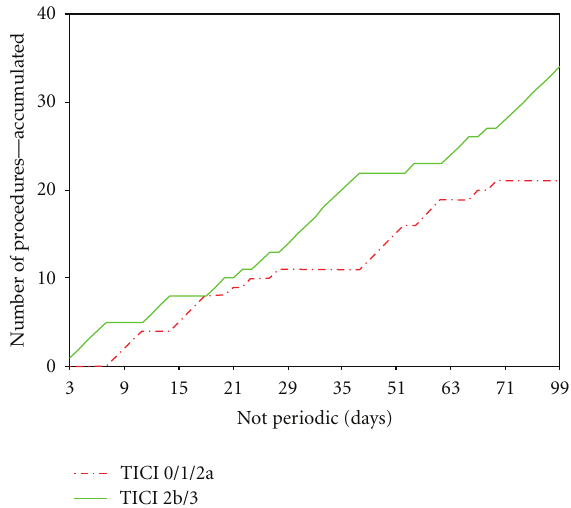
Figure 5: The diverging graphs demonstrate the increasing pre- ponderance of potentially beneficial TICI 2b/3 reperfusion results (green line) over the frustrating recanalization results (TICI 0/1/2a, red line) in the time course of the observation period. This observation is partially attributable to our institutional learning curve.